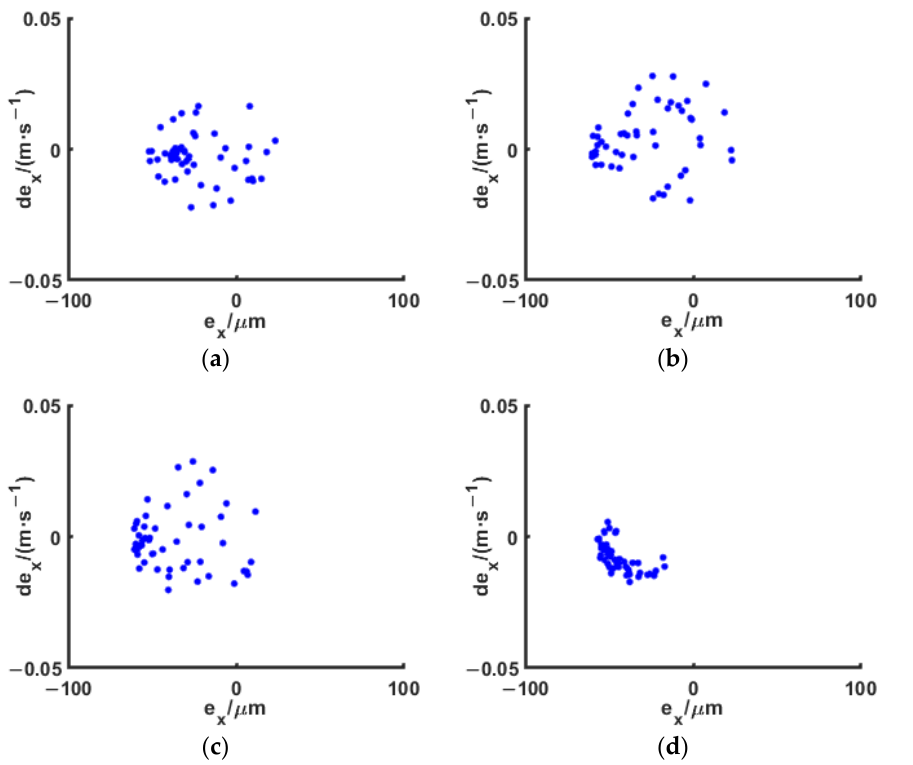
Figure 10. Poincare mapping at different driving speeds. ( a ) ω = 25. ( b ) ω = 30. ( c ) ω = 35. ( d ) ω =